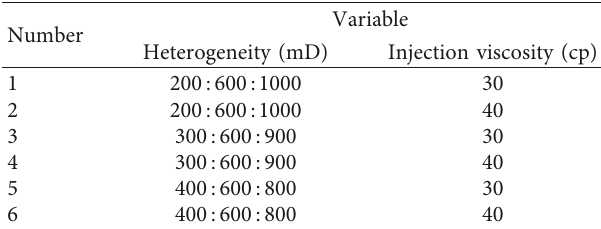
Figure 5: Layout of measurement points in the laboratory model. (a) Schematic diagram of the laboratory model. (b) Photo of the laboratory model. Table 1: Experimental conditions. Table 2: Formula of simulated formation